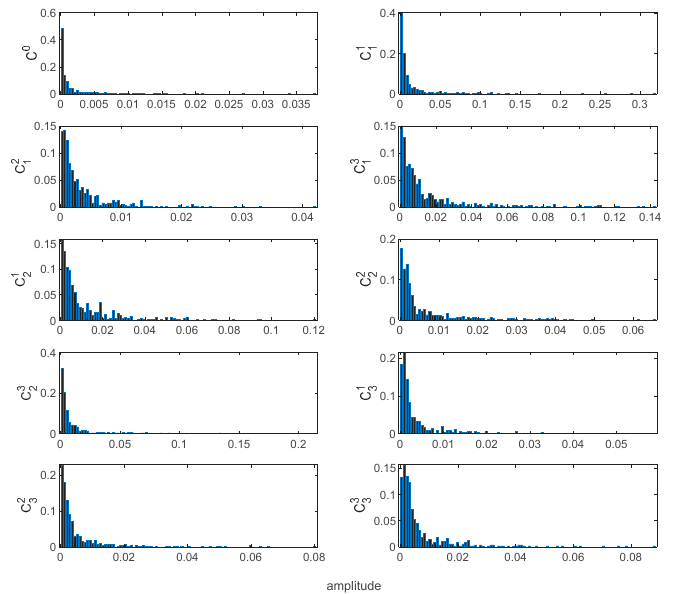
Figure 8. Histogram of probability distribution of FFT spectrum based on 10 health states.